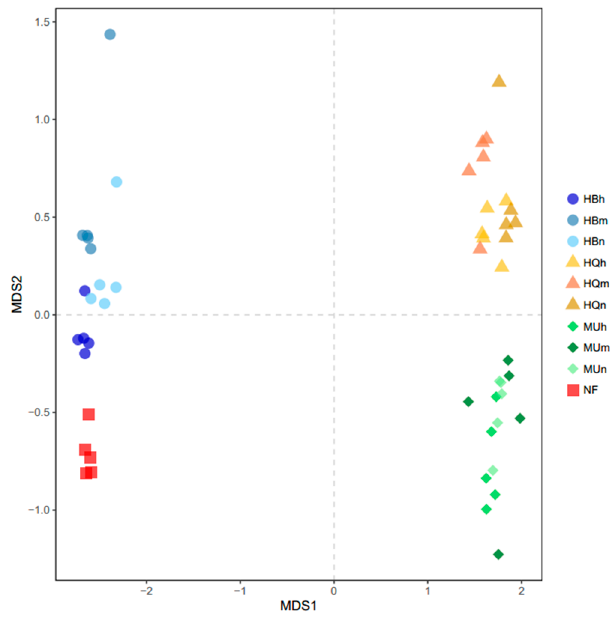
Figure 7. EM fungal community structure based on operational taxonomic units (OTUs), as determined by non-metric multidimensional scaling (NMDS), stress= 0.078.